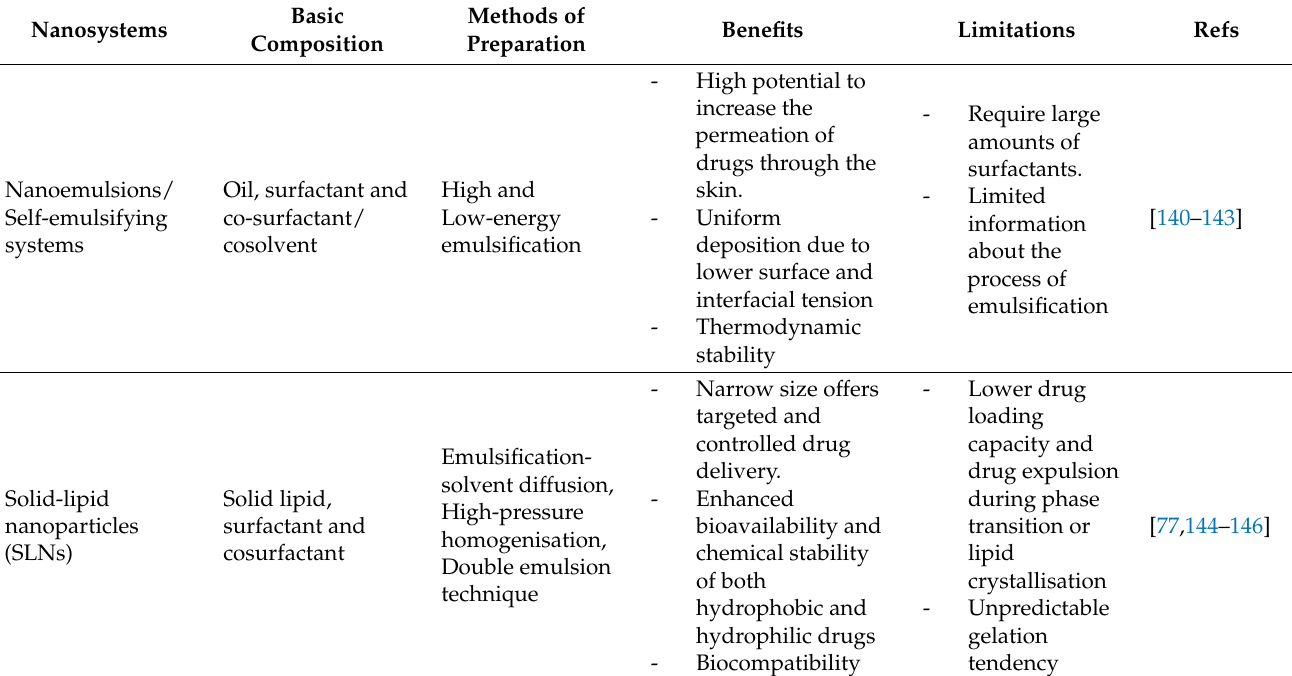
Table 2. A brief description of conventional liposomes and particulate carrier